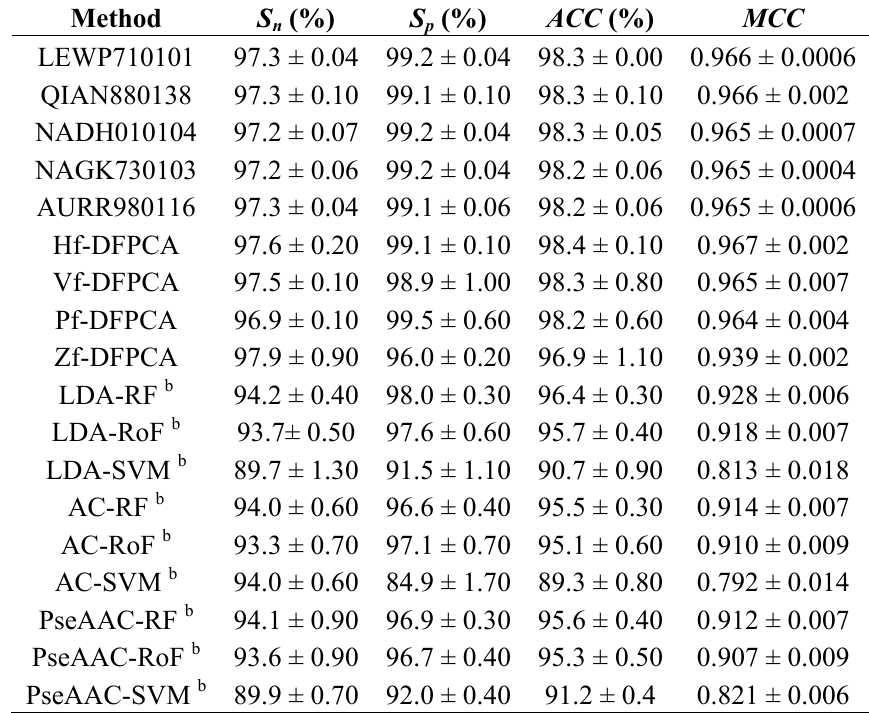
Table 5. Performance comparison of different PPI methods using Shen’s dataset a in the 10 CV